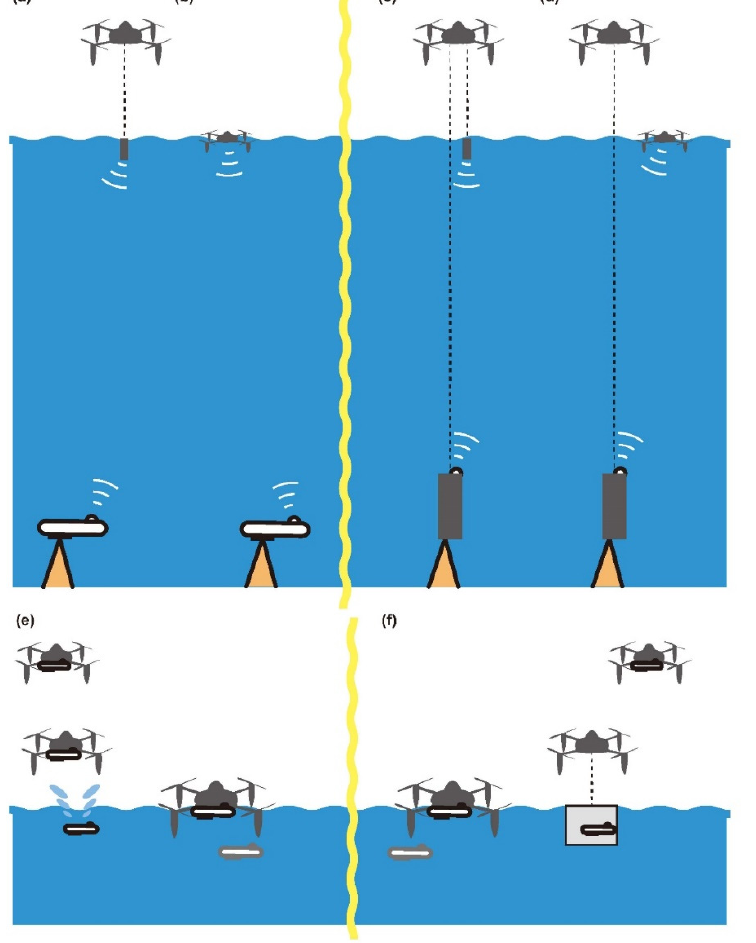
Figure 2. Experimental setup in this study. ( a ) Underwater communication experiment with two UAVs for determining stability at a distance. ( b ) Determination of sea-surface sway of a UAV used as a buoy.